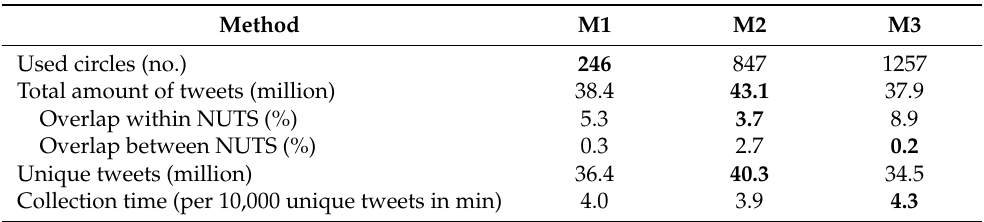
Table 2. Number of used circles, total amount of tweets, and collection time (best performances are in bold). Method M1 M2 M3 Used circles (no.) 246 847 1257 Total amount of tweets (million) 38.4 43.1 37.9 Overlap within NUTS (%) 5.3 3.7 8.9 Overlap between NUTS (%) 0.3 2.7 0.2 Unique tweets (million) 36.4 40.3 34.5 Collection time (per 10,000 unique tweets in min) 4.0 3.9